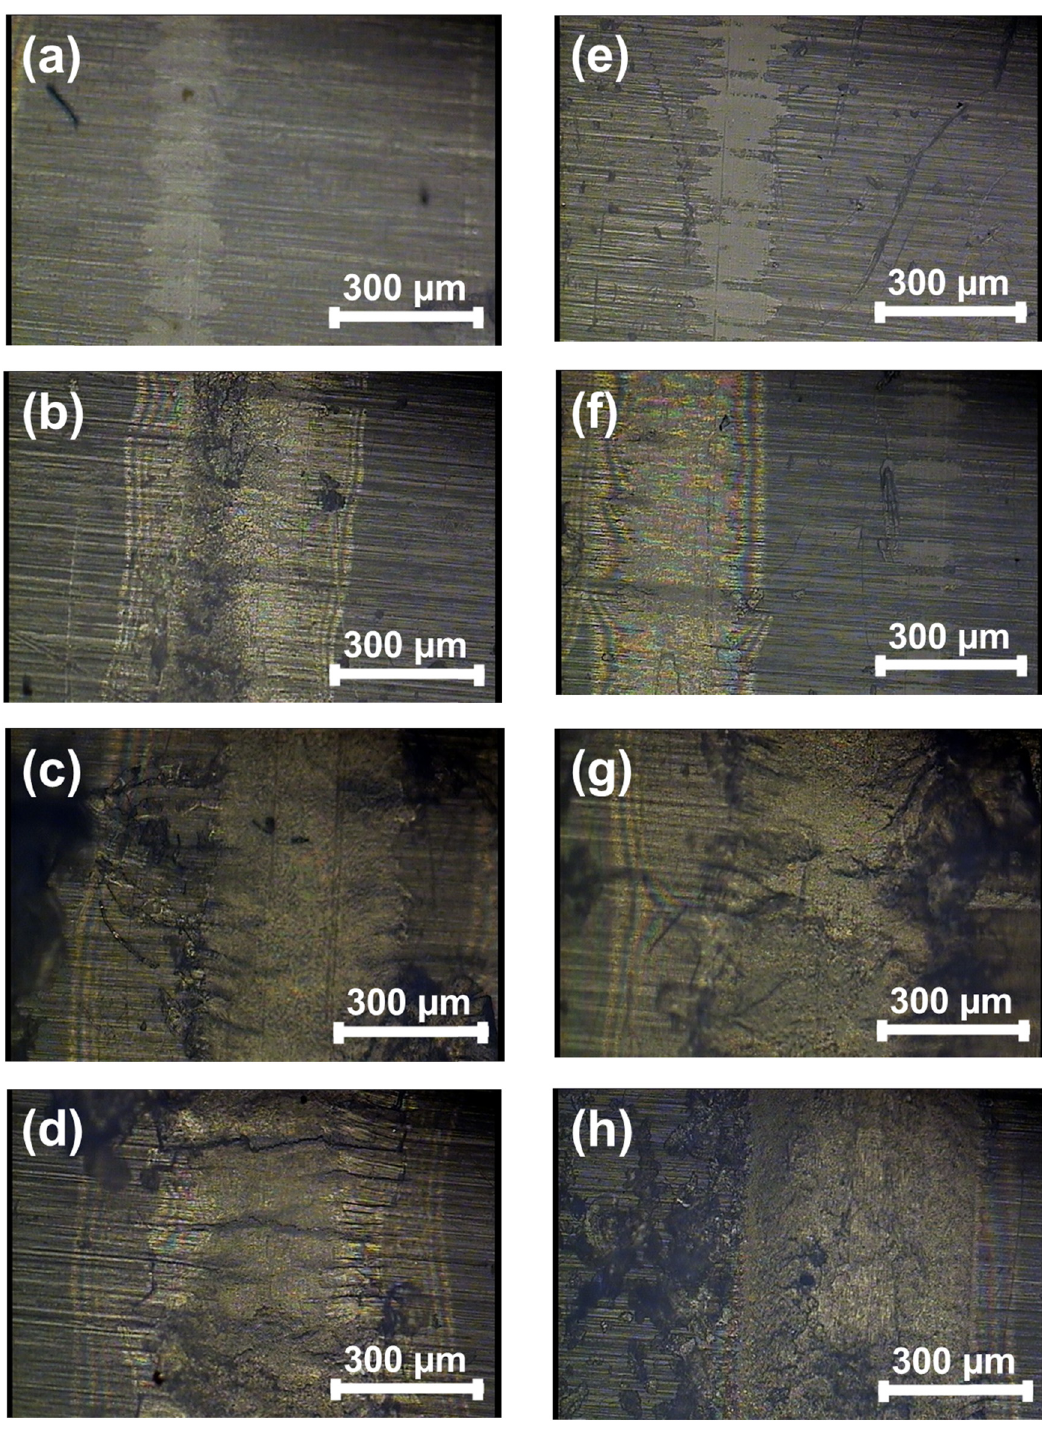
Figure 5: Optical microscopy of wear tracks produced at 1, 3, 6, and 10 N on samples made at T = 160°C ( left column: a, b, c, and d ) and T = 170°C ( right column, e, f, g, and h ) , respectively. Wear tracks are perpendicular to the textured lines of the